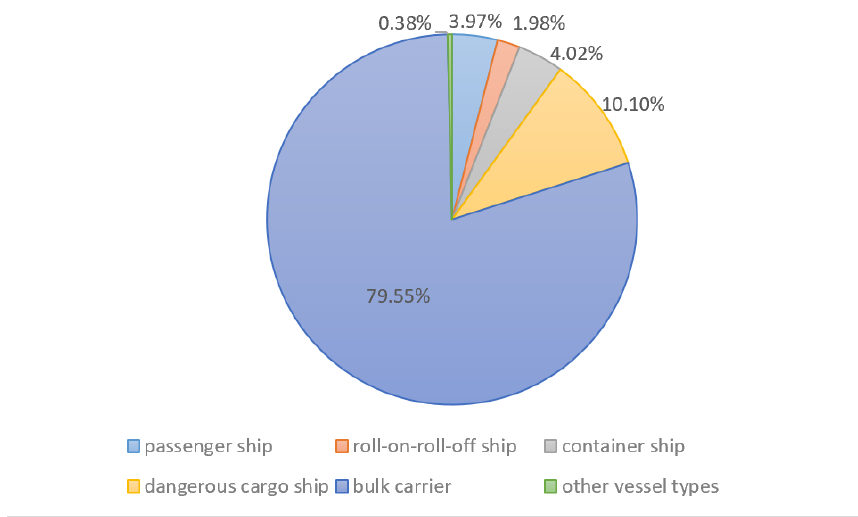
Figure 3. Type of ships in the Three Gorges Dam in 2016.